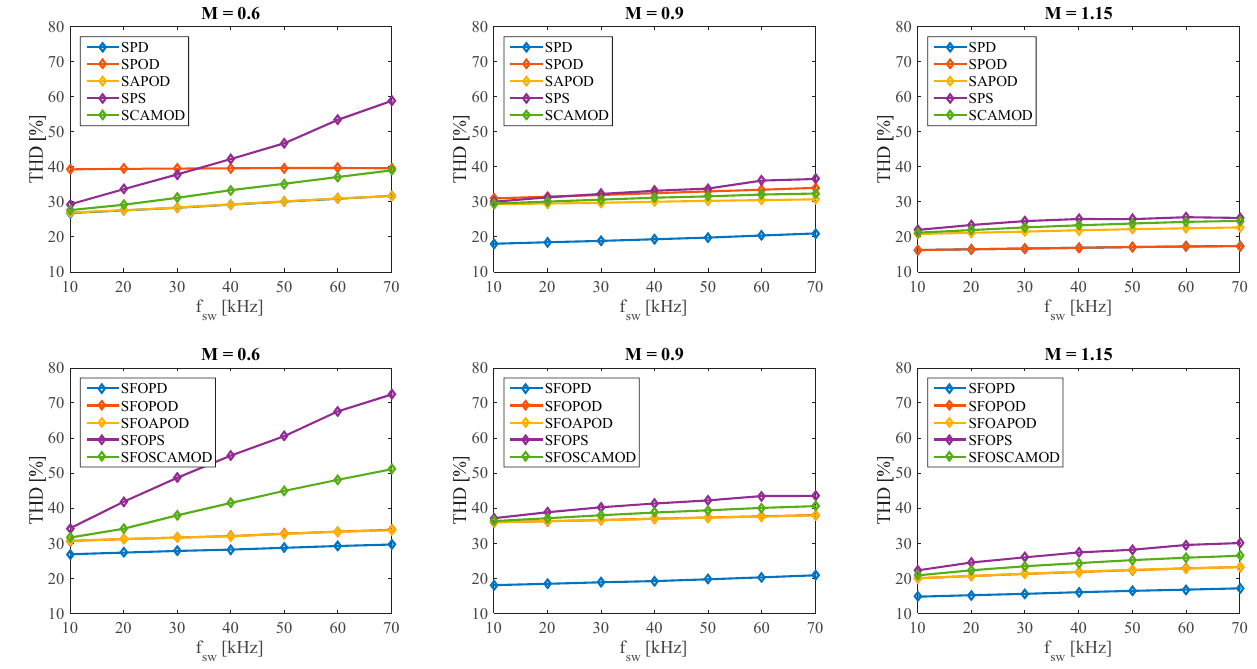
Figure 19. Experimental comparison of THD% trends as a function of the switching frequency among the schemes under test. Table 6. Voltage waveform